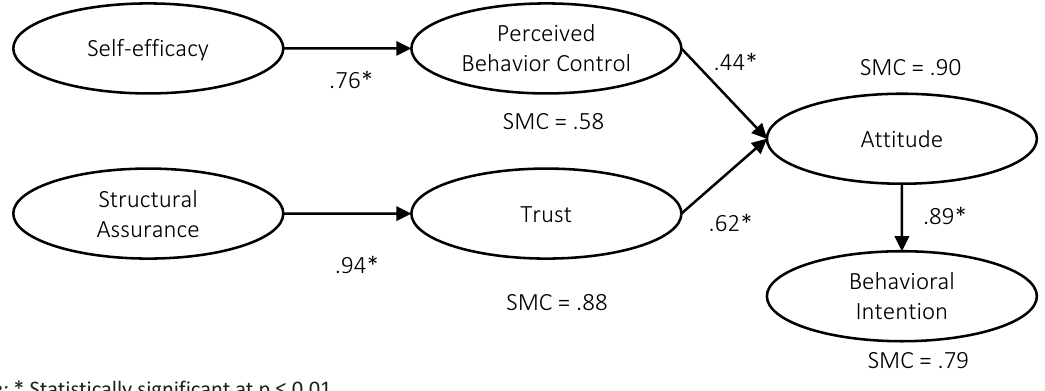
Figure 1. Structural